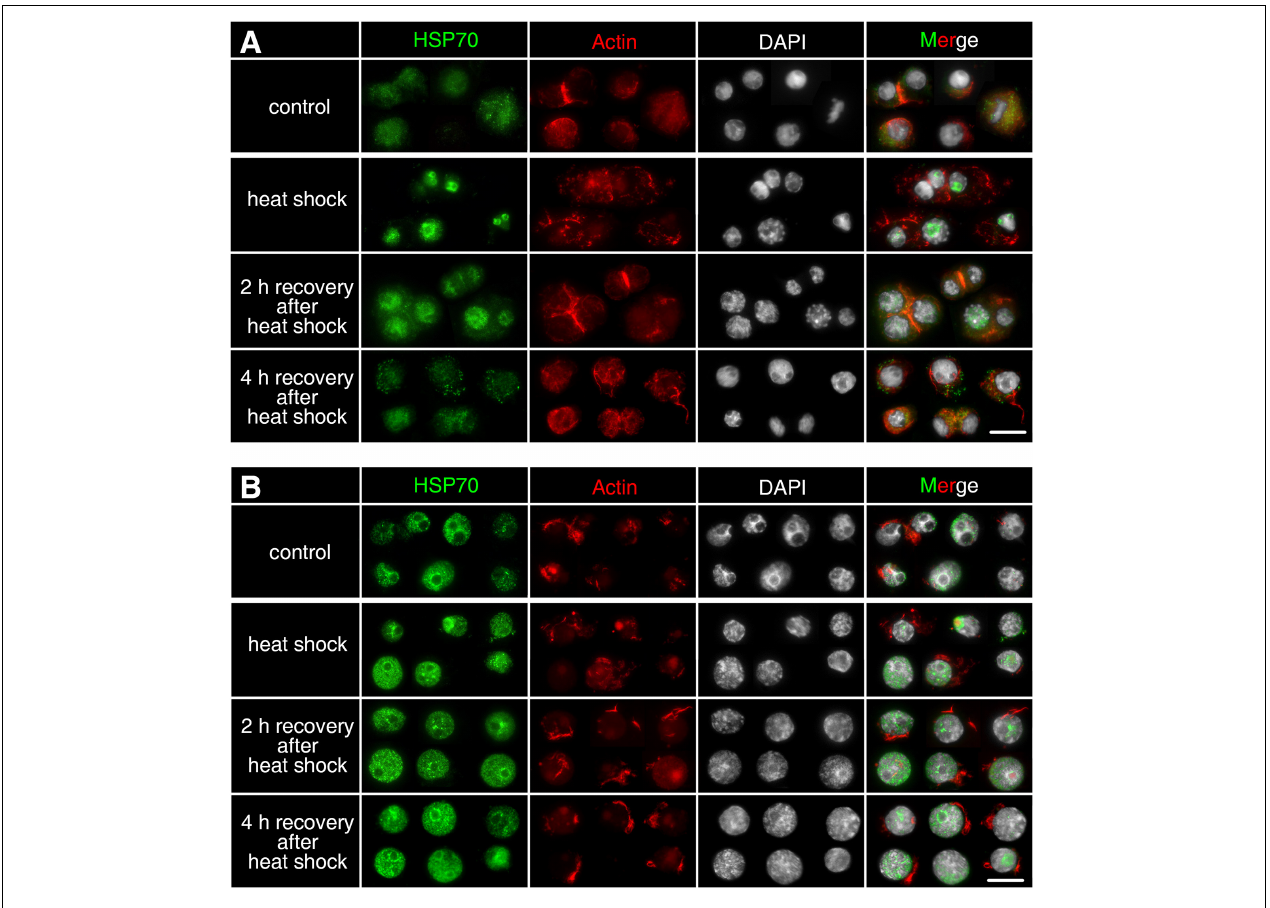
FIGURE 5 | Subcellular localization of HSP70B protein upon heat shock in developing cells from D. magna asexually produced embryos (A) and diapausing cells from D. magna sexually produced embryos (B) . Actin microfilament networks were stained with Phalloidin in red and chromatin with DAPI in white. (A) In developing cells, HSP70B protein signals localized in nucleus after 1-h heat shock at 33 ± 0.1 ◦ C, cytosolic HSP70B protein was strongly reduced. After 2-h recovery at 20 ± 0.1 ◦ C, nuclear HSP70B was still detectable, whereas cytosolic HSP70B protein reappeared. After 4-h recovery at 20 ± 0.1 ◦ C, HSP70B protein was not detectable in nucleus, a pre-heat homogenous cytosolic distribution was observed. (B) One-hour heat shock at 40 ± 0.1 ◦ C did not cause distribution changes of HSP70B in diapausing cells. Scale bars = 10 µ